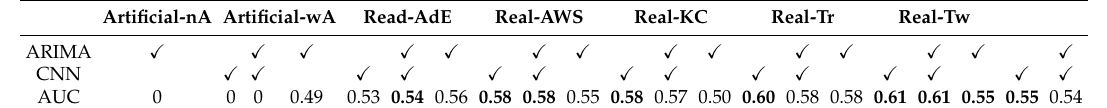
Table 4. Ablation study on the NAB dataset.